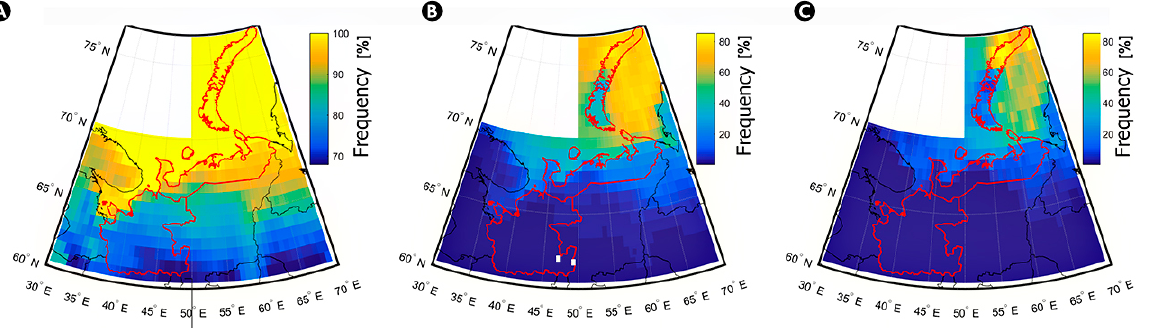
Figure 5. Spatial distribution of cold stress occurrence according to UTCI for the summer period (June-August) with gradations: moderate cold stress (A), strong cold stress (B) and very strong cold stress